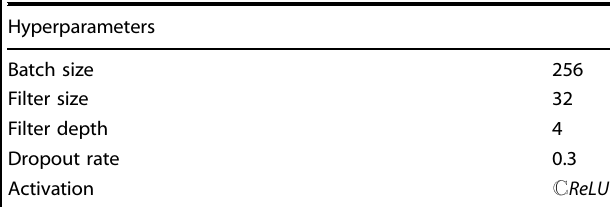
Table 2. Selected hyperparameters for FCU-Net deep-neural